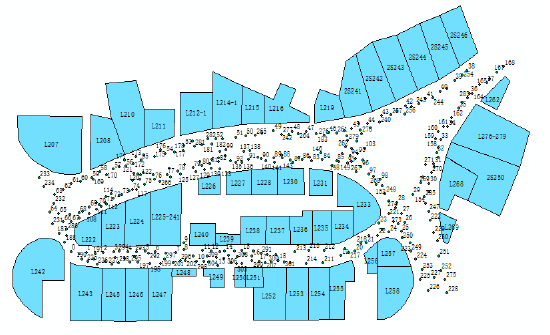
Figure 8. Distribution of track